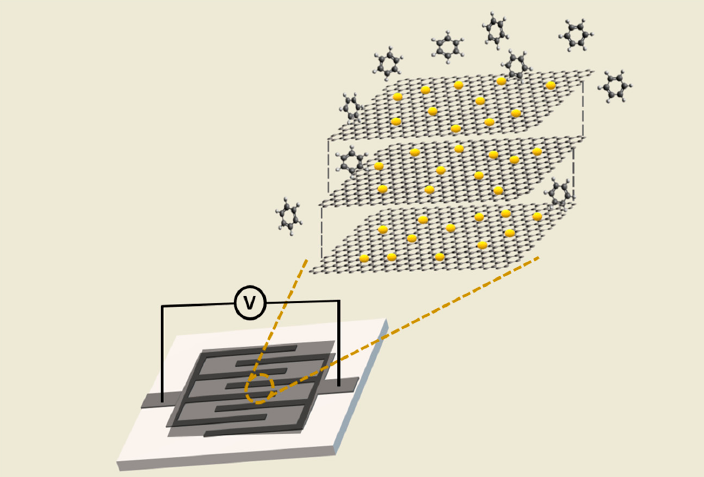
Figure 1. Sensor configuration: A film consisting of a random organization of few layer graphene flakes, decorated with metal oxide nanoparticle coats, and interdigitated electrodes screen-printed onto an alumina substrate. The resistance of the film is measured between the two contact pads printed on the substrate. The substrate includes a printed platinum heating meander on its backside that can be used to raise the operating temperature of the sensor above the ambient temperature.